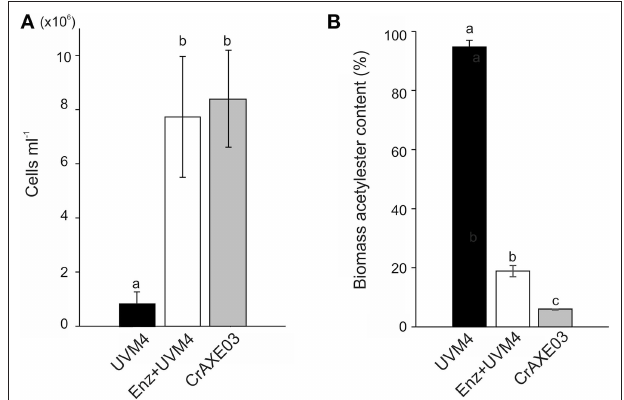
FIGURE 6 | Cultivation of the UVM4 strain and the transgenic strain CrAXE03 of C. reinhardtii in the presence of wheat biomass. (A) Cell numbers. (B) Acetylester content in the wheat straw biomass. The strains were cultivated in the minimal medium containing wheat biomass (MM + Biomass) for 10 days. “Enz + ” indicates that a commercial acetylxylan esterase at the concentration of 2U mL − 1 was added at the start of cultivation. a, b, and c indicate statistically significant difference ( P <